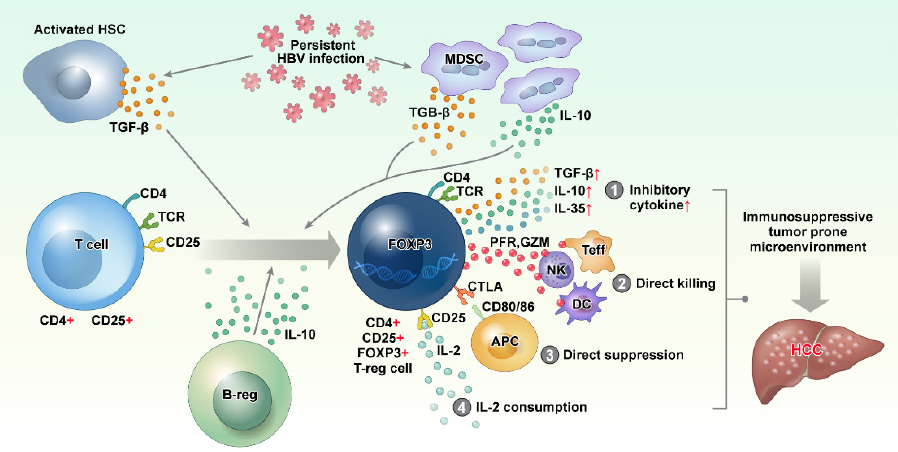
Figure 2. Persistent HBV infection activates hepatic stellate cells (HSCs) and recruits myeloid-derived suppressor cells (MDSC), resulting in the increase in immune-suppressive cytokines, such as TGF- β and IL-10. These immunosuppressive cytokines cause the differentiation of CD4+ CD25+ T cells into CD4+ CD25+ FOXP3 regulatory T cells (Treg cell). Although the function of Treg cells is essential for limiting host damage, persistent HBV infection causes Treg cells to contribute to a tumor-prone immune microenvironment by (1) producing inhibitory cytokines, (2) direct killing of effector cells via perforin and granzyme, (3) direct suppression of antigen presentation cells via CTLA4–CD80/86 interaction, and (4) IL-2 consumption via CD25. HBV: hepatitis B virus, IL: interleukin, TGF: transforming growth factor.